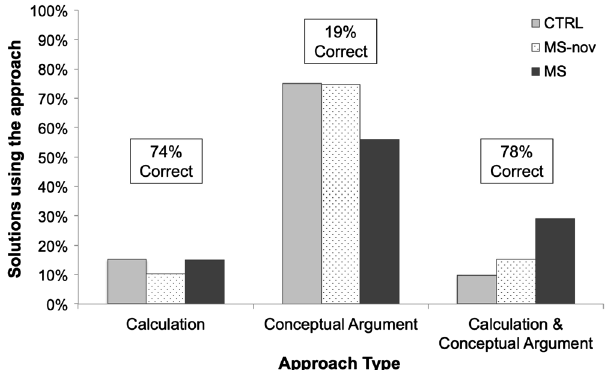
FIG. 5. Approaches used on the qualitative judgment question (exploding blocks) — calculation, conceptual argument, and both calculation and conceptual argument — along with the percentage of correct answers produced by each